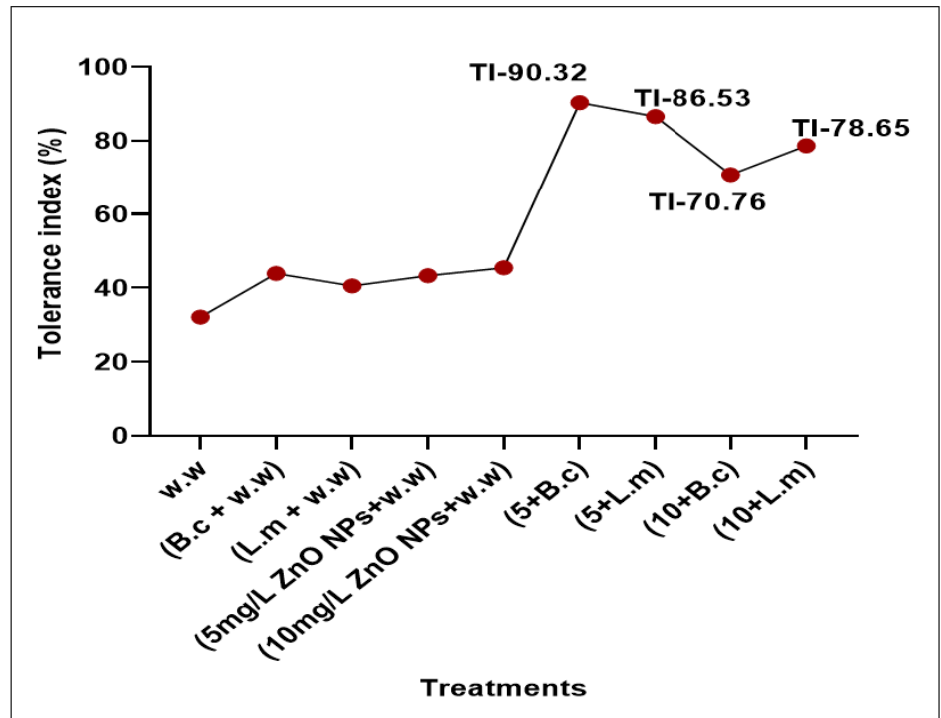
Figure 8. Tolerance index (TI) of rice plants grown in HM polluted water contained 5 and 10 mg/L ZnO NPs raised from seeds primed with bacterial strains ( B. cereus and L. macroides ). Waste water, B.c + w.w ( B. cereus + waste water)., L.m + w.w ( L. macroides + waste water) . , 5 ZnO NPs + w.w (5